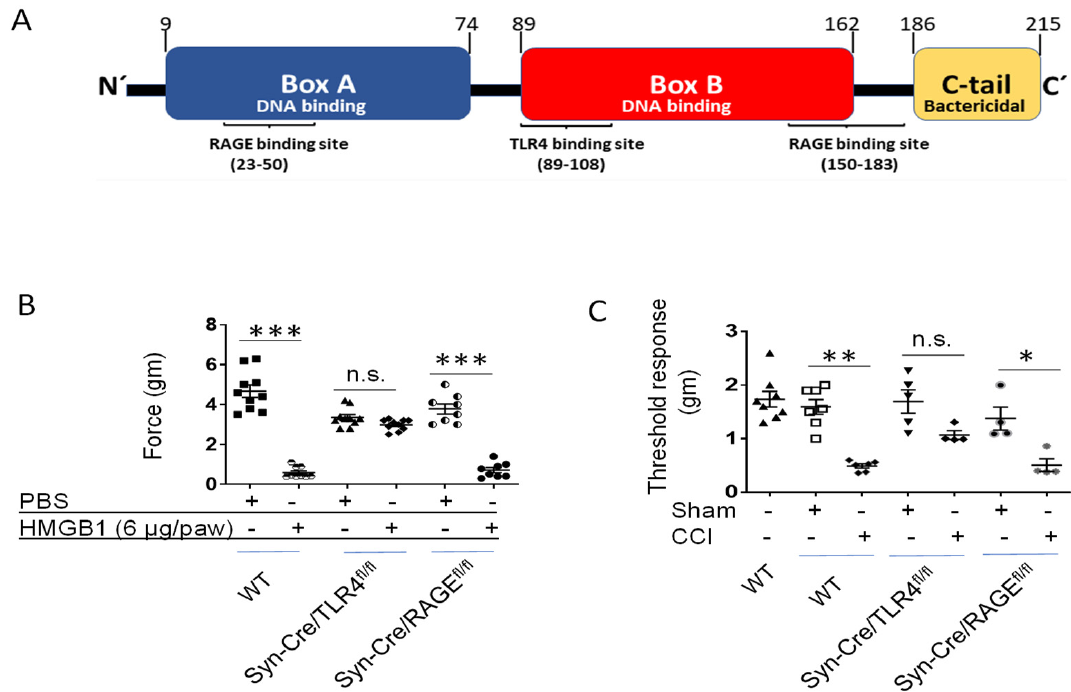
Figure 3. Neuronal TLR4, not RAGE, mediates HMGB1-induced nociceptive response. ( A ). Location of receptor binding sites in the HMGB1 molecule. The human HMGB1 protein expresses 214 amino acid residues and contains three functional domains: two DNA binding regions termed Box A and Box B, and a bactericidal C-terminal tail. The three ligand binding sites of the HMGB1 protein: RAGE binding site (23–50 aa’), TLR4 binding site (89–108 aa’) [31] and RAGE binding site (150–183 aa’). ( B ). Wild type (C57BL/6), Syn-Cre/TLR4 fl/fl and Syn-Cre/RAGE fl/fl mice (generated by crossing Rage fl/fl (from Dr. Daolin Tang, Dallas, TX, USA) or TLR4 fl/fl (Jackson Laboratories, Hudson, NY, USA) to mice carried the Synapsin I promoter-driven Cre recombinanse transgene (Jackson Laboratories)) had intra-plantar injection of HMGB1 (6 µ g/paw) or vehicle (PBS) on hindpaw, and 5 h later mechanical hypersensitivity (dynamic plantar aesthesiometer) was assessed. ( n = 8–10 mice per group. ***: p < 0.0001). n.s.: not significant. ( C ). Wild type (WT), Syn-Cre/TLR4 fl/fl and Syn-Cre/RAGE fl/fl mice (male, 8–12 weeks old) were subjected to sciatic nerve ligation surgery (CCI) or sham surgery. Two weeks after sciatic nerve ligation (or sham) surgery, mechanical hypersensitivity (von Frey filament) was assessed. n = 4–8 per group. *: p < 0.02. **: p < 0.001. n.s.: not